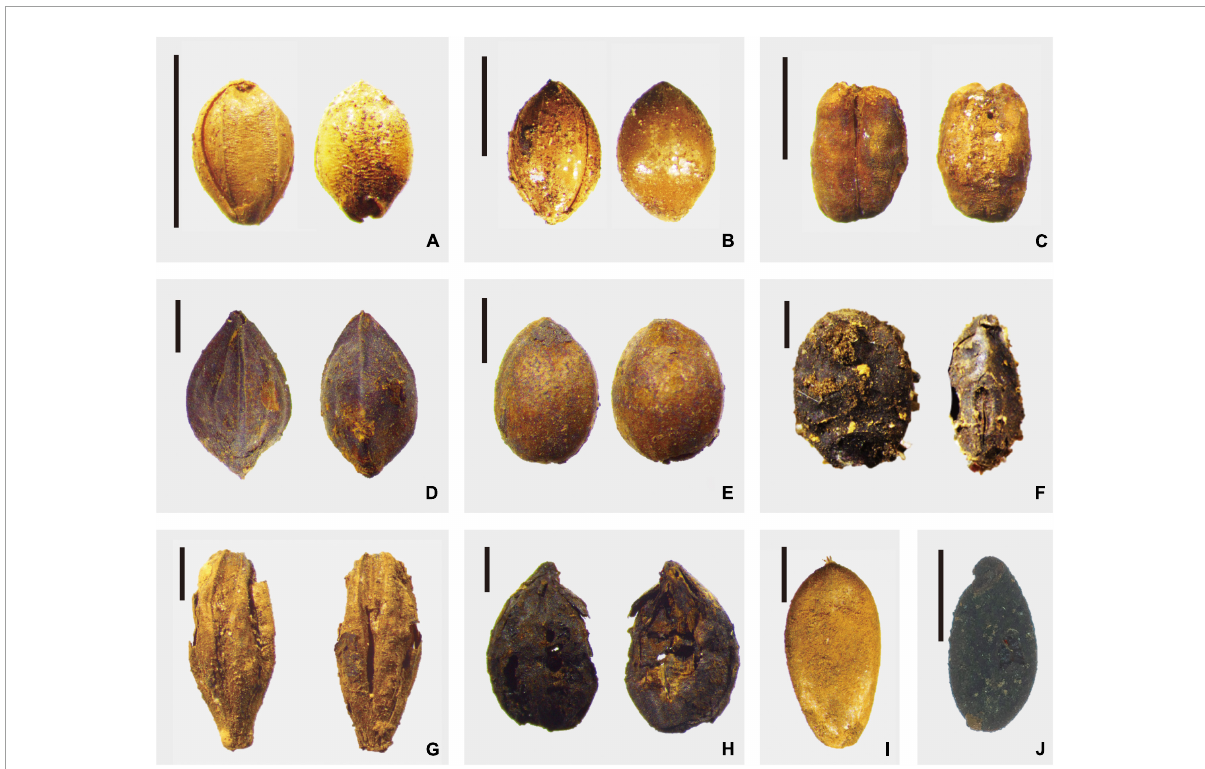
FIGURE2 Crop remains unearthed from the Chashancun cemetery. (A) Setaria italica ; (B) Panicum miliaceum ; (C) Triticum aestivum ; (D) Fagopyrum esculentum ; (E) Cannabis sativa sub. Sativa ; (F) Leguminosae ; (G) Hordeum vulgare ; (H) Hordeum vulgare var. coeleste ; (I) Cucumis melo ; and (J) Linum usitatissimum (Scale bar: 2